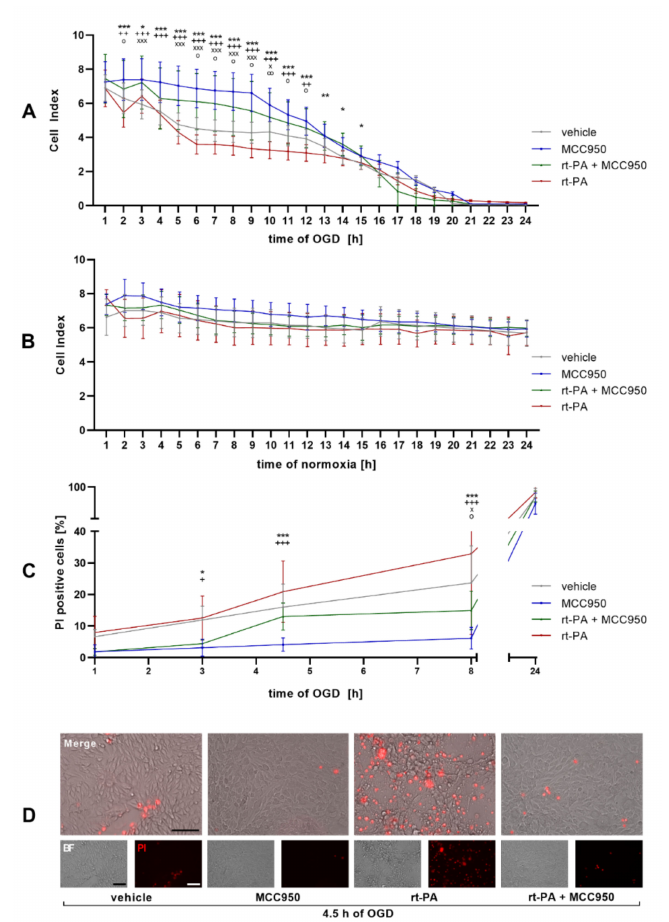
Figure 1. NLRP3 inhibition stabilizes the Cell Index of endothelial cells and reduces endothelial cell death under OGD. ( A ) The Cell Index over a period of 24 h of OGD (1% O 2 , 5% CO 2 , 95% humidity, 37 ◦ C, 1 g/L glucose) as measured with the ACEA xCELLigence DP system. bEnd5 were either treated with vehicle, MCC950, rt-PA, or rt-PA and MCC950 ( n = 24 out of 3 independent experiments). ( B ) The Cell Index over a period of 24 h of normoxia. bEnd5 were either treated with vehicle, MCC950, rt-PA, or rt-PA and MCC950 ( n = 24 out of 3 independent experiments). ( C ) Percentage of apoptotic, propidium iodide (PI) positive, bEnd5 cells per well after 1 h, 3 h, 4.5 h, 8 h, and 24 h of OGD depending on the treatment regime ( n = 15 out of 3 independent experiments). ( D ) Representative microscopic brightfield images of bEnd5 after 4.5 h of OGD and visualization of treatment-dependent PI (red) uptake; 10 × objective; scale bar = 100 µ m. Data was analyzed by 1-way ANOVA with post hoc Tukey adjustment * p < 0.05; ** p < 0.01; and *** p < 0.001. Significance as indicated by * refers to the comparison between the rt-PA treated group and the rt-PA + MCC950 treated group, by + , ++ p < 0.01, +++ p < 0.001 to the comparison between the vehicle treated group and the MCC950 treated group, by o , oo p < 0.01 to the comparison between the vehicle treated group and the rt-PA treated group and by x , xxx p < 0.001 to the comparison between vehicle and the rt-PA + MCC950 treated group. Merged images are enlarged by a factor of